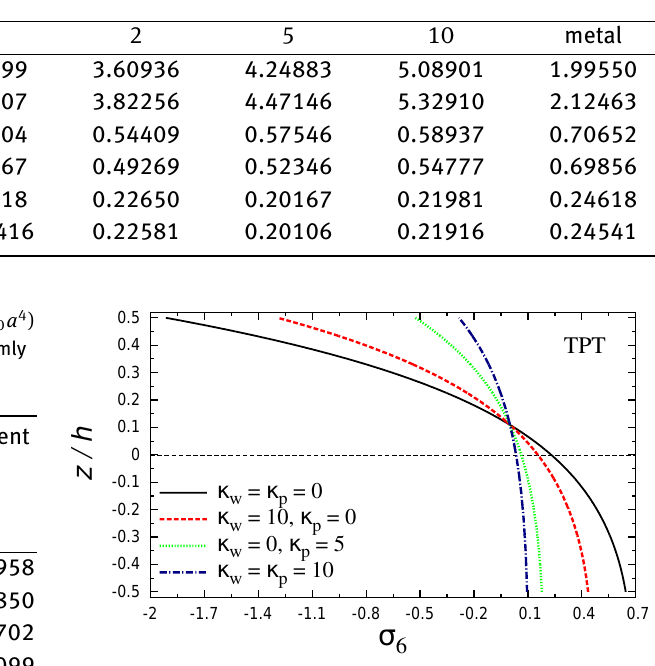
Table 2: Nondimensionalized stresses σ i in FG square plates under sinusoidal loads ( a = 10 h ). k